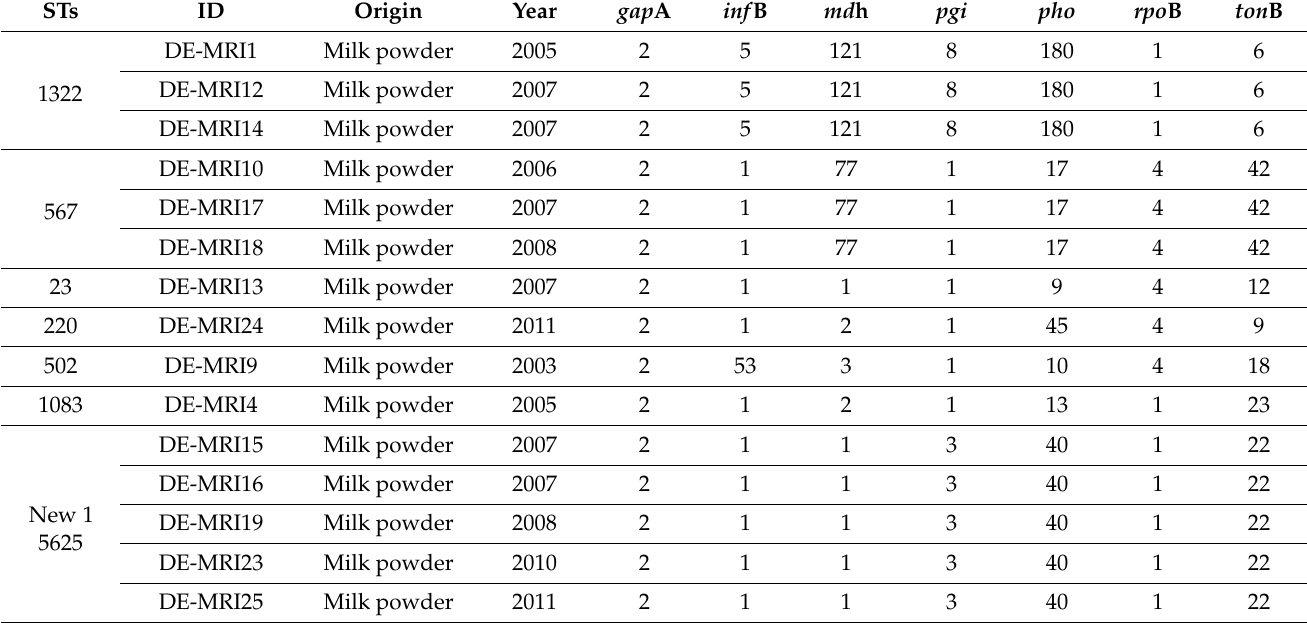
Table 1. Description of the typed and novel STs and allelic profiles of the untyped K. pneumoniae strains recovered from milk powder samples produced in Germany between